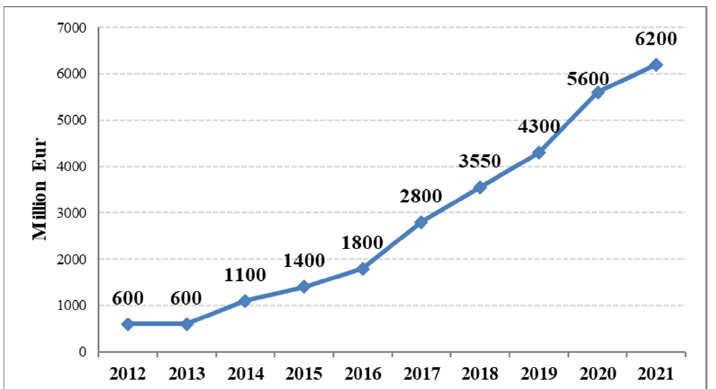
Figure 7. Online sales value in Romania 2012–2020 (without services, only tangible goods included) Source data: own representation based on GpeC blog.